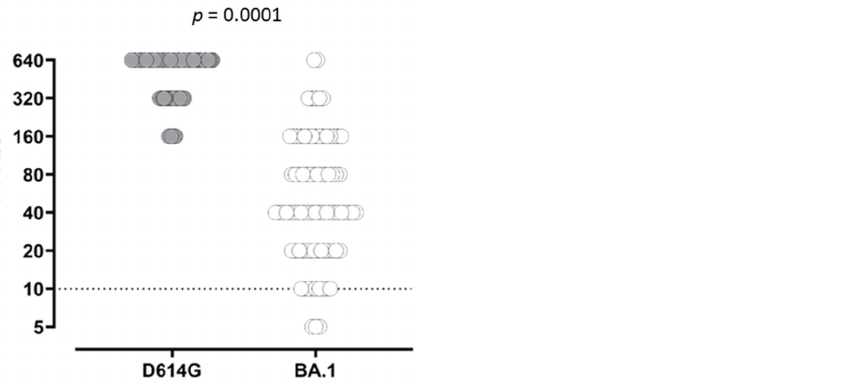
Figure 2. SARS-CoV-2 NT Abs response against wild-type strain D614G (grey dots) and BA.1 variant (white dots) was measured.